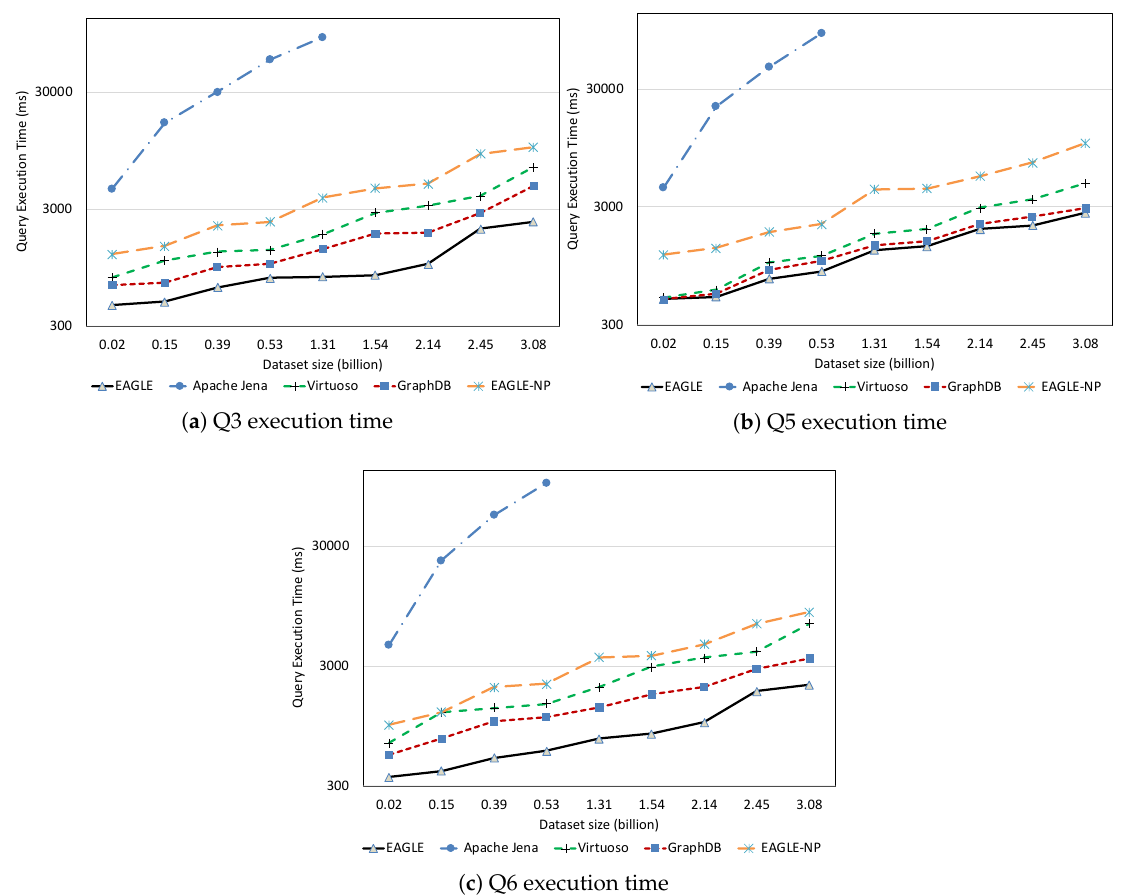
Figure 22. Temporal queries execution time with respect to dataset size (in